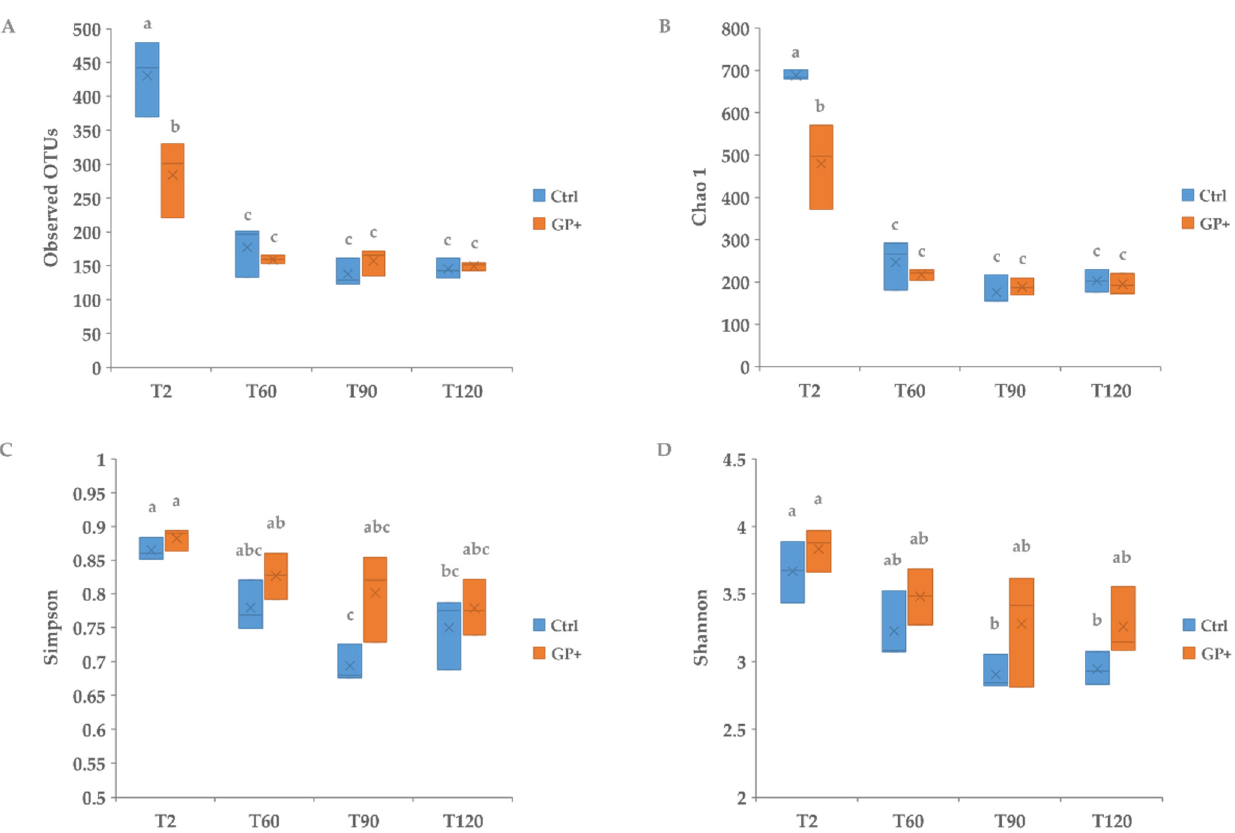
Figure 2. Alpha diversity measured as observed OTUs ( A ), Chao1 ( B ), Simpson ( C ) and Shannon ( D ) indices in cheese after 2 (T2), 60 (T60), 90 (T90) and 120 (T120) days of ripening, obtained from raw milk of ewes fed standard diet (Ctrl) and grape pomace diet (GP+). Box-plots labeled with different letters are significantly different from each other.